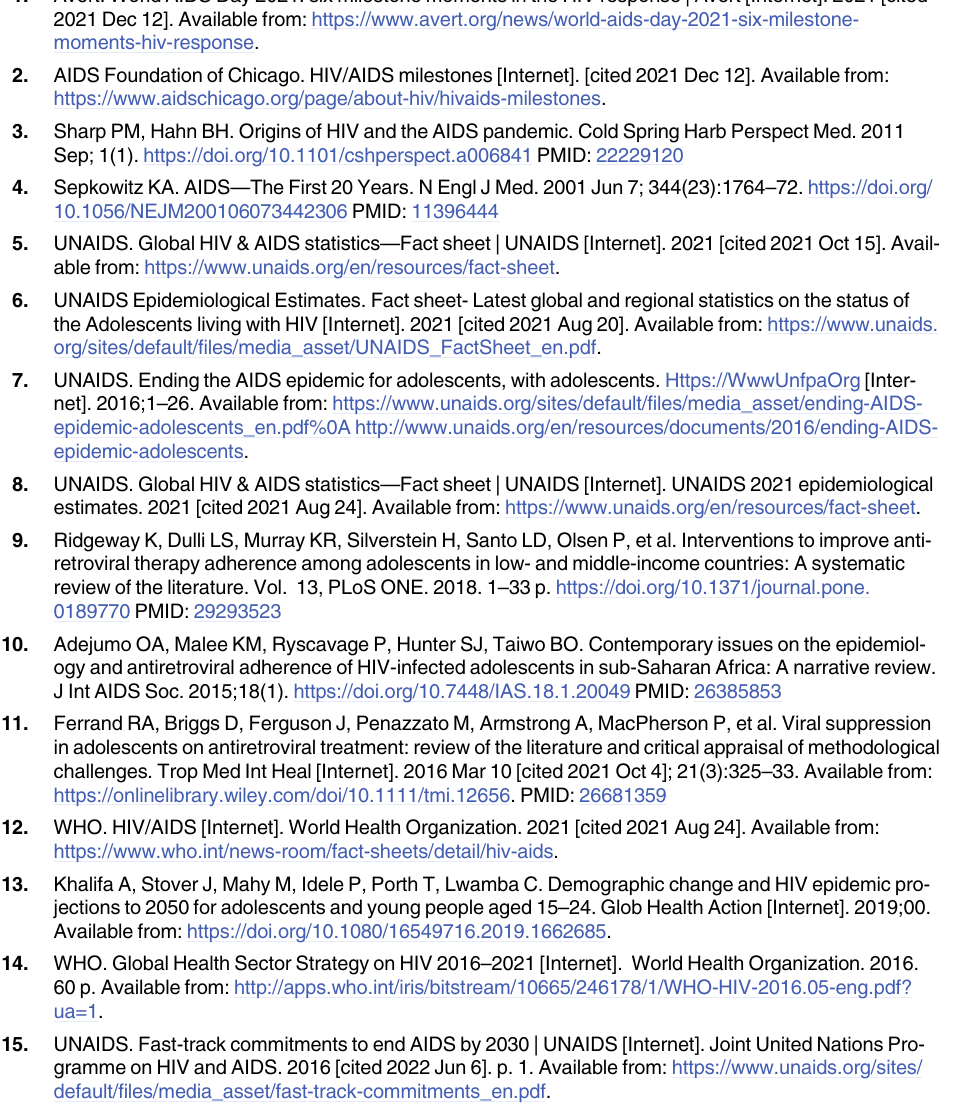
S1 Table. Search strategy for the systematic literature review. S2 Table. PRISMA-P 2015